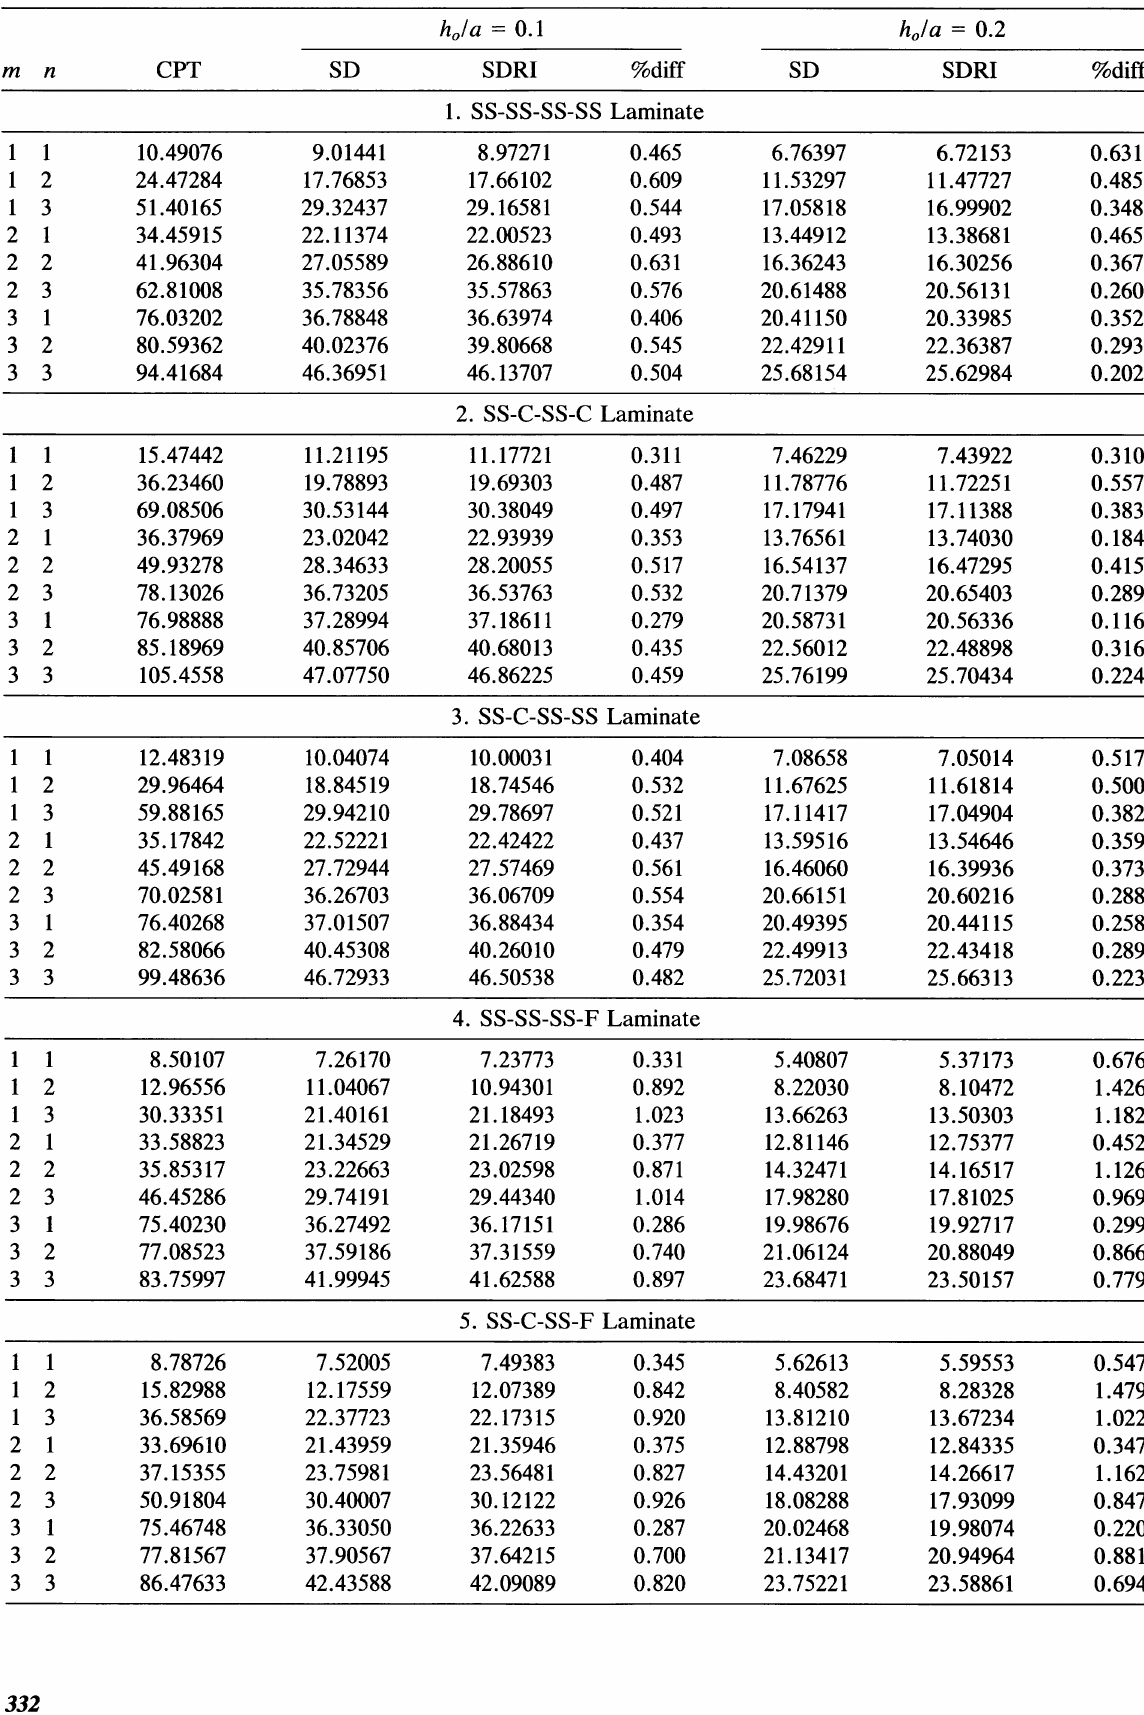
Table 6. Comparison of Classical (CPT), Shear Deformation (SD) only, and Shear Deformation with Rotatory = Inertia (SDRI) Solutions for Nine (m, n 1,2,3) Free Vibration Frequencies of Five-Layer Cross-Ply Square Laminates ho/a = 0.1 ho/a =